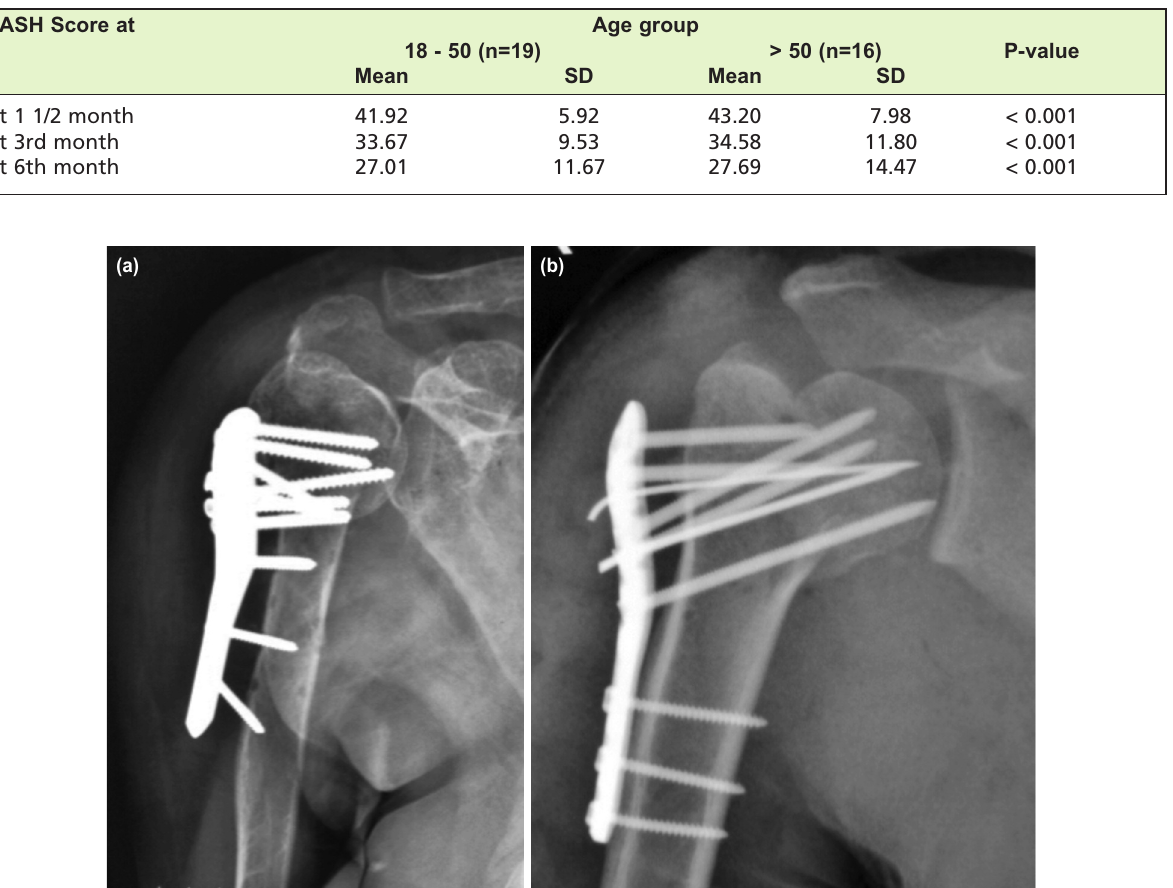
(a, b) Incidence of complications in the study population. Fig. 1: